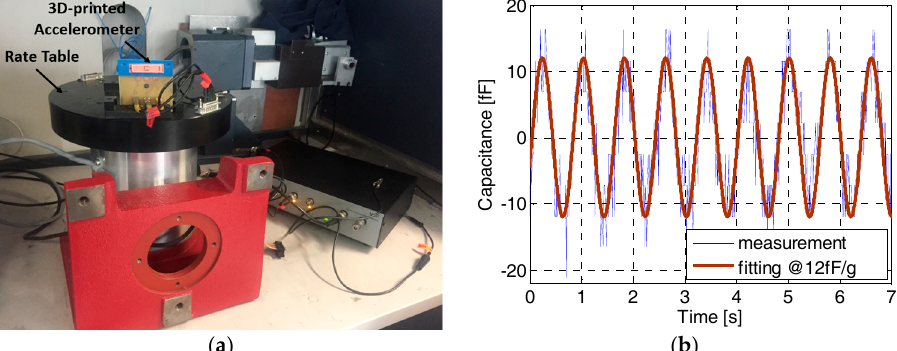
Figure 2. ( a ) Experimental set-up showing the PCB vertically installed on the turning plate of a rate table; ( b ) Capacitance variation due to external acceleration.